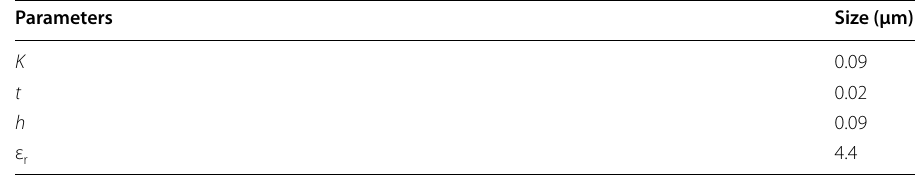
Table 1 Dimensions of DBC-SRR structure